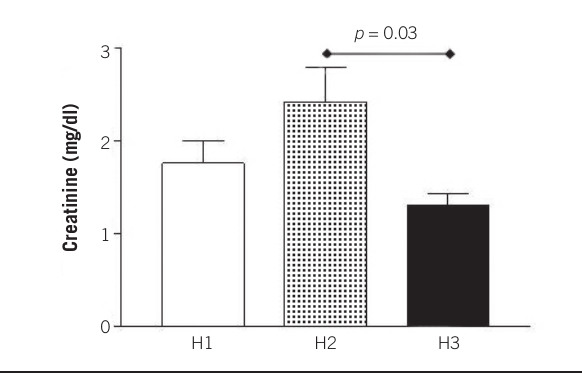
figuRE 1 − Creatinine plasma levels (mg/dl) in the groups of kidney transplant patients (H1, H2, and H3) according to the number of HLA matches H1: fewer than three matches; H2: three matches; H3: more than three matches.